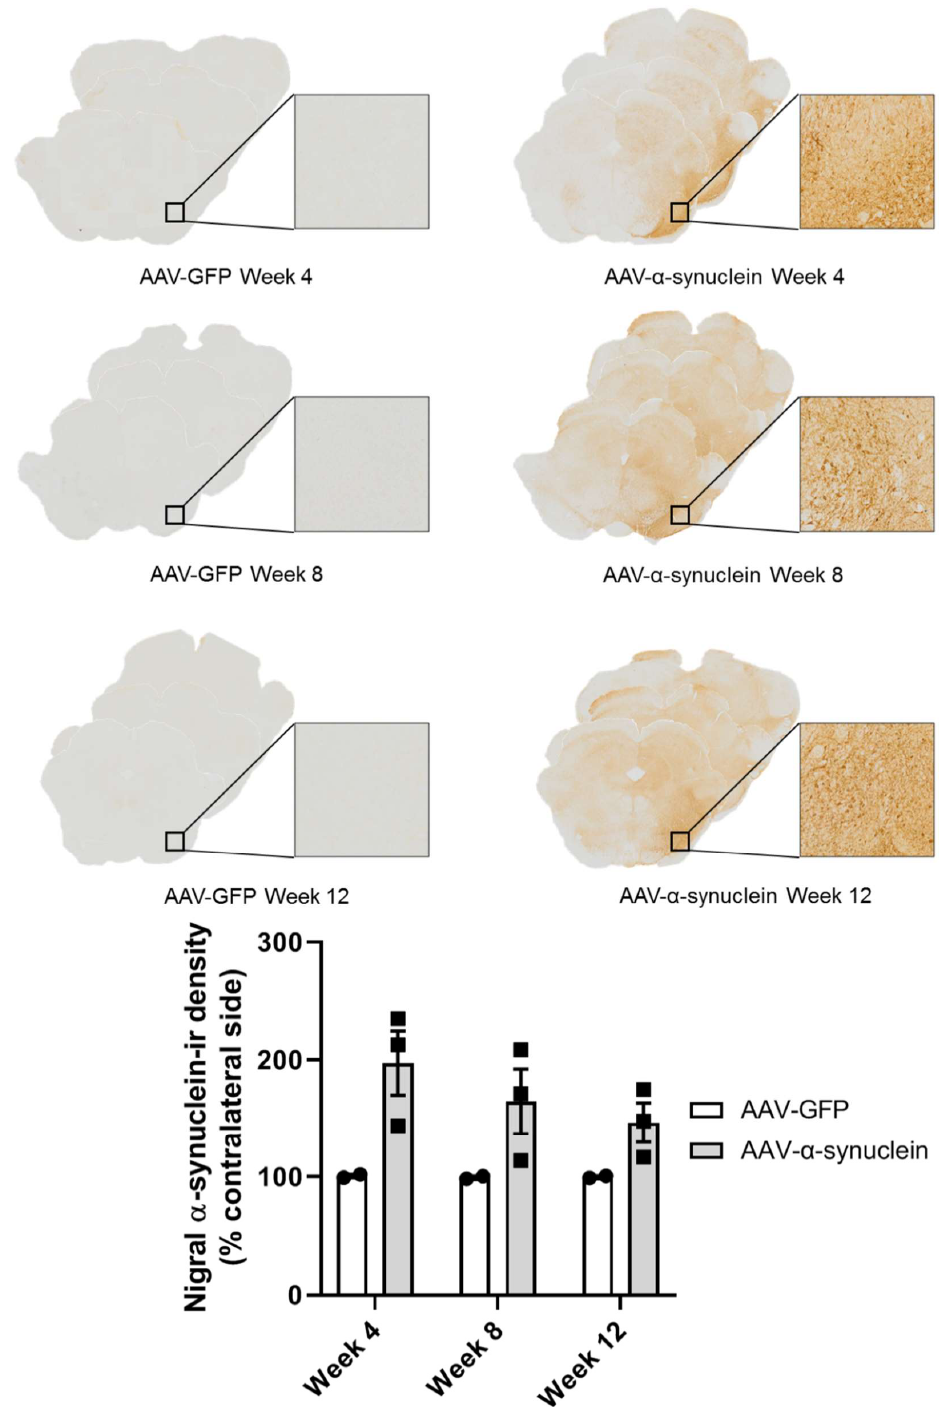
Figure 1. Expression of human α -synuclein in the substantia nigra after injection of AAV- α -synuclein. Top panel: photomicrographs showing α -synuclein expression in the substantia nigra at different time-points after the administration of the viral vectors. Bottom panel: graph showing the relative quantification of the expression of human α -synuclein in the substantia nigra using optical density image analyses of sections labelled by immunohistochemistry for human α -synuclein. Note that animals that received AAV- α -synuclein expressed human α -synuclein protein in the substantia nigra, but animals that received AAV-GFP did not. Data are represented as mean ± SEM with 2–3 animals per group.